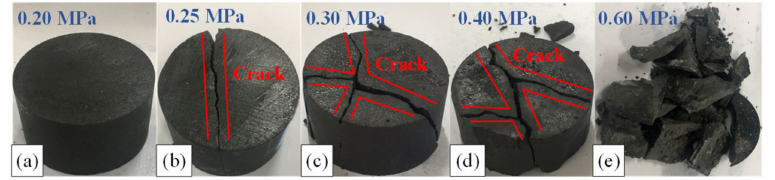
Figure 10. Failure morphology of the mudstone samples subjected to single-impact loads. ( a ) 0.20 MPa; ( b ) 0.25 MPa; ( c ) 0.30 MPa; ( d ) 0.40 MPa; ( e ) 0.60